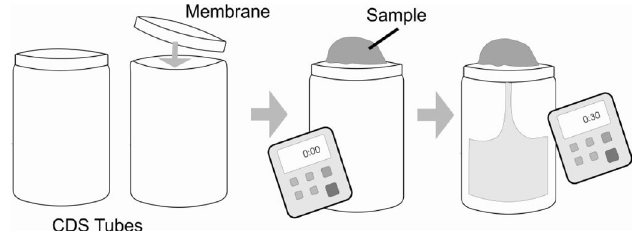
FIGURE 2 – Classification stage. Sample is classified according to UN Packing Groups I, II or III. Sample is placed on a membrane which covers the CDS tube. Time taken to corrode the membrane is recorded. Based on the category that the agent was assigned previously and the time taken to corrode the membrane, the samples are classified into Groups I, II or III ( In Vitro